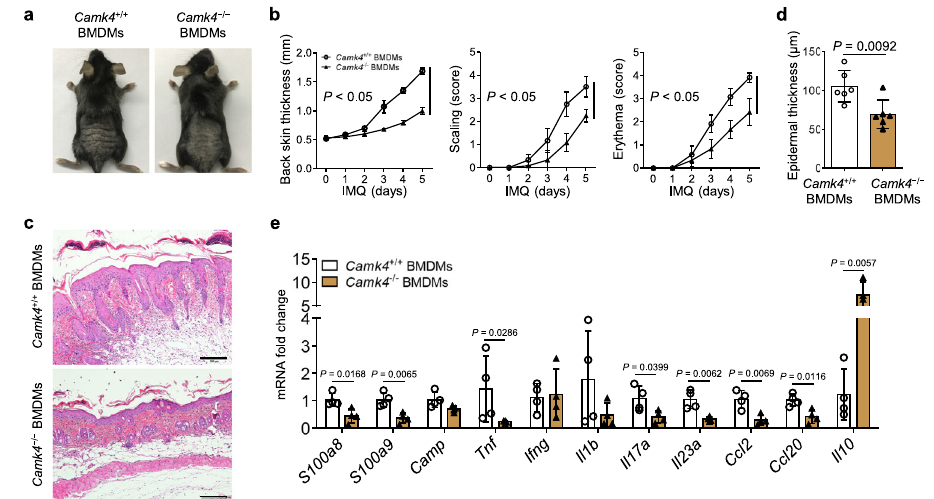
a – d N =6 per group from two independent experiments. e The expression of pathogenic factors in the skin of IMQ-treated mice as determined by quantitative PCR ( n =4 biologically independent samples). Data are shown as mean±SD. For ( b , d ), two-sided unpaired Student ’ s t test; for ( e ), two-sided Mann – Whitney test and two-sided unpaired Student ’ s t test. Source data are provided as a Source Data fi